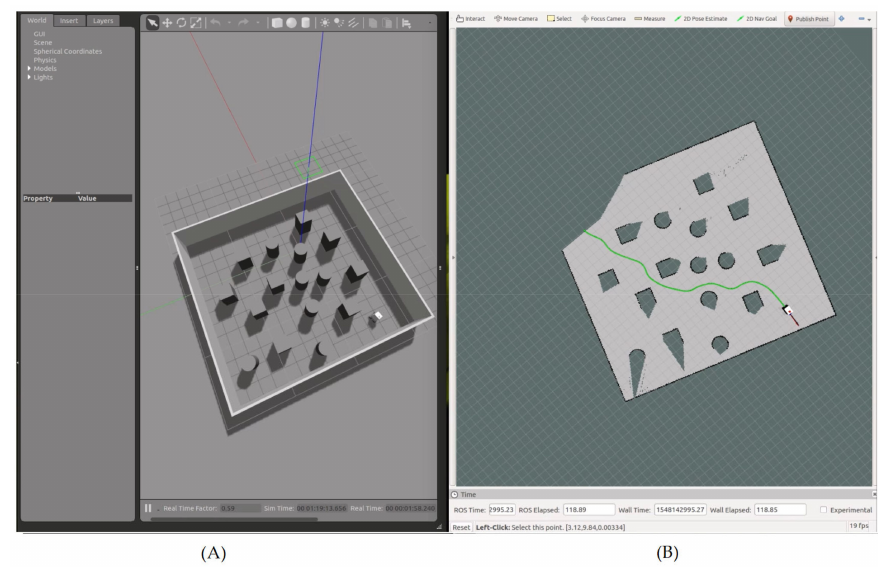
Figure 8. Simulation results showing the path of the robot from its initial location to waypoint n1, with the navigation area on Gazebo ( A ), and the simulated state of the robot on Rviz ( B ).